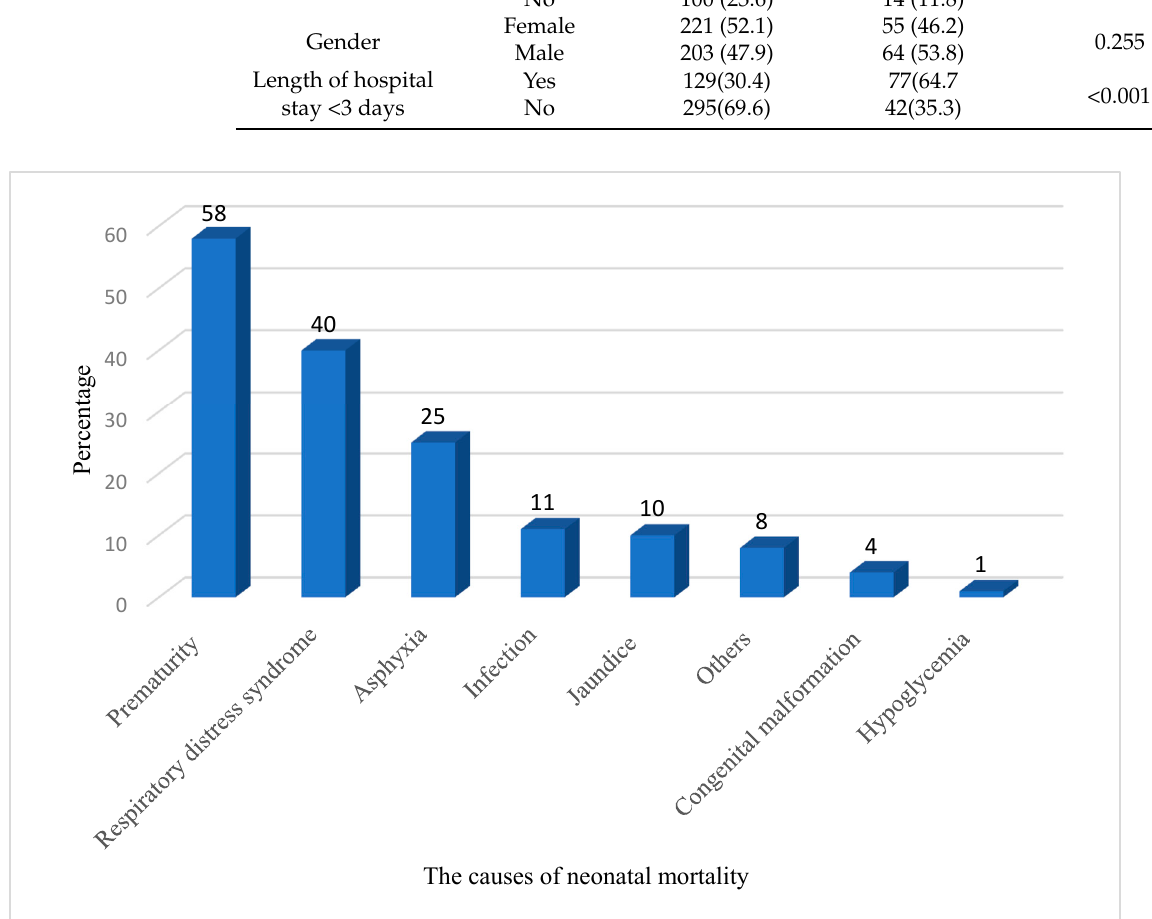
Figure 1. Common causes of neonatal mortality in the neonatal intensive care unit of Gadarif hos- pital.